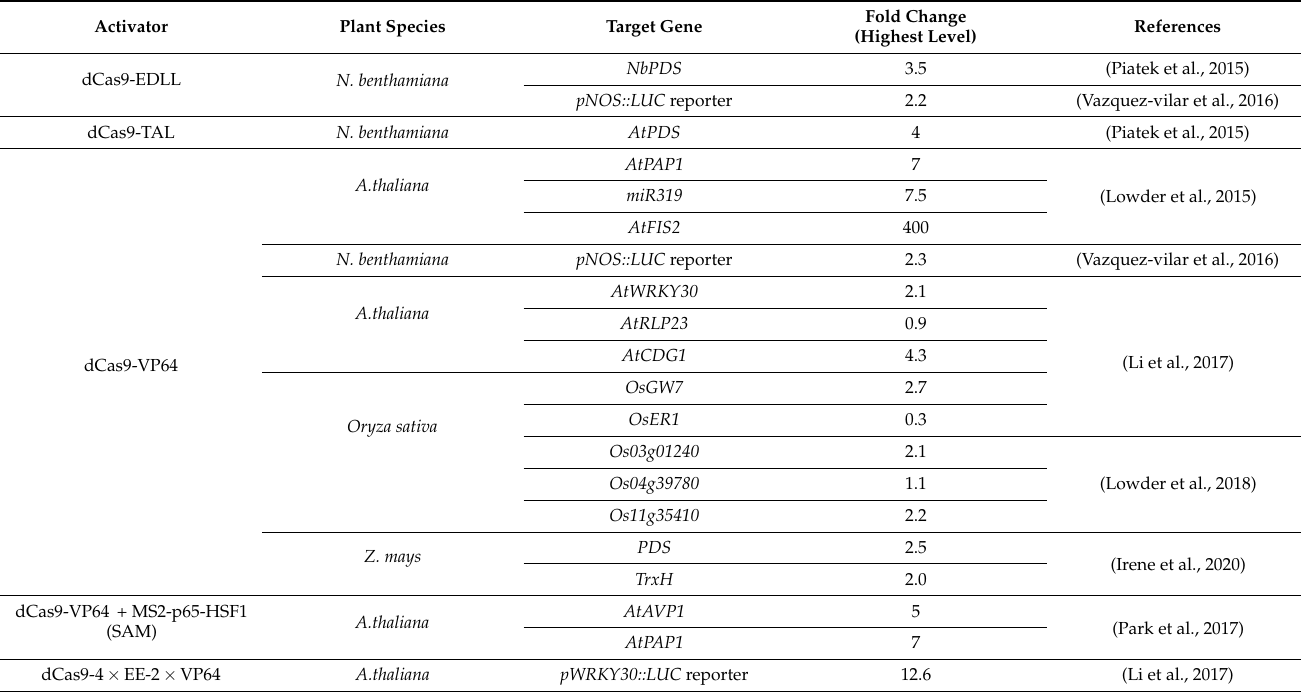
Table 2. Applications of the CRISPR-activation system in